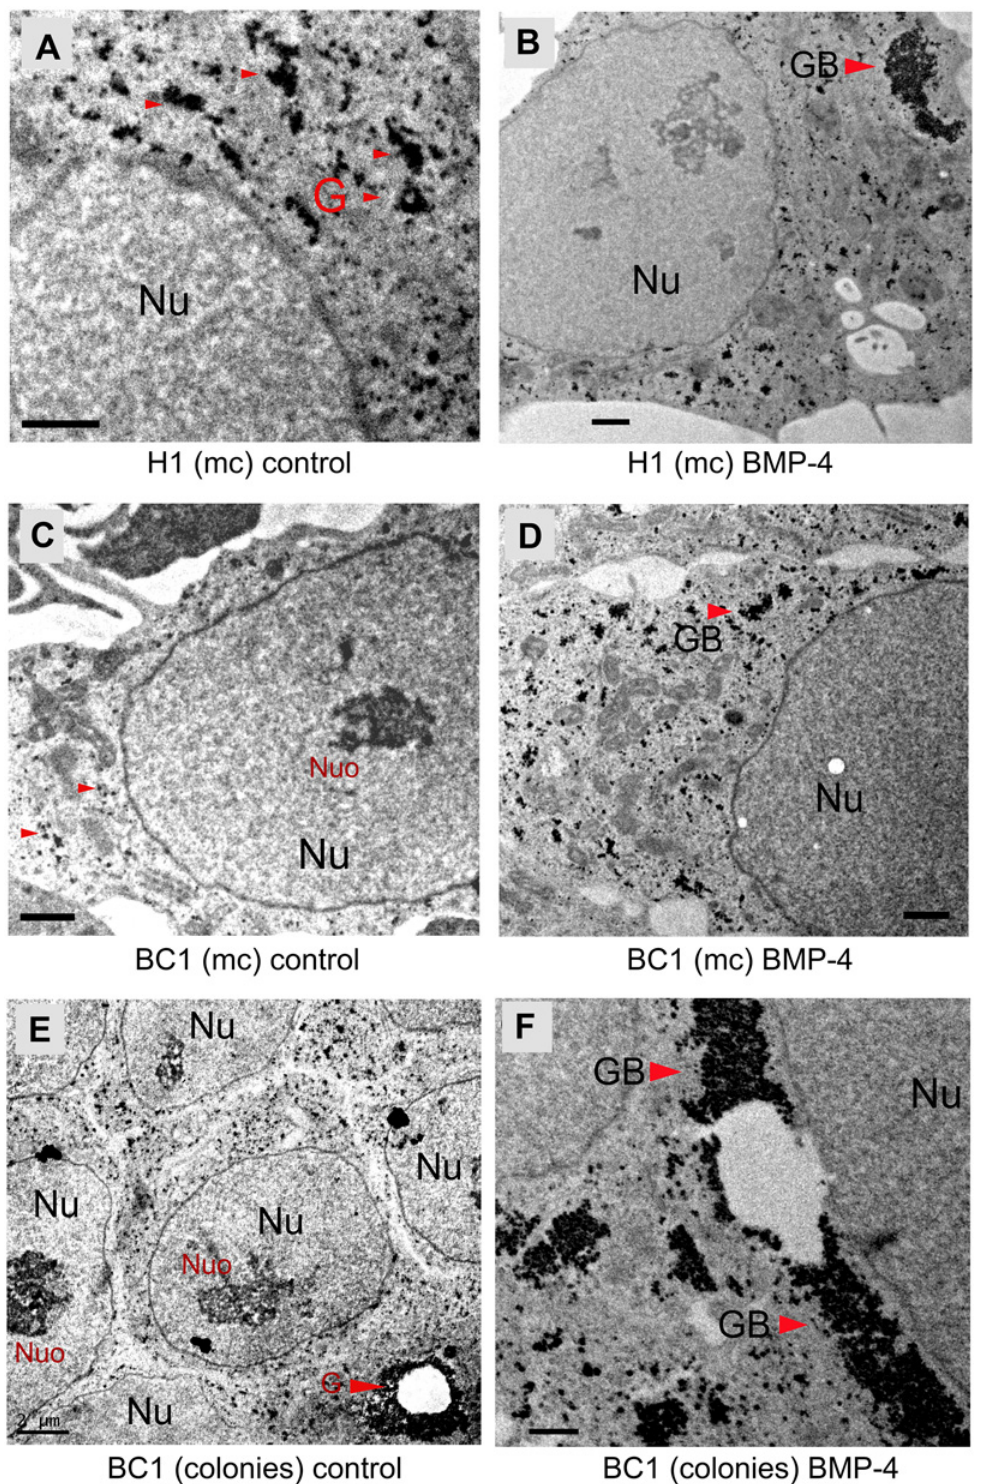
Fig 2. Transmission electron micrograph (TEM) analysis of glycogen synthesis in hPSCs. ( A, C ) Representative images of untreated H1 and BC1 cells grown as a non-colony type monolayer (mc) on 2.5% Matrigel. ( E ) Untreated BC1 cells grown as colonies on Matrigel. (B, D, F) Representative images of hPSCs (left panel) treated with 100 ng/mL of BMP-4. The red colored arrowheads indicate stained glycogen aggregates in the cytoplasm of the cell.